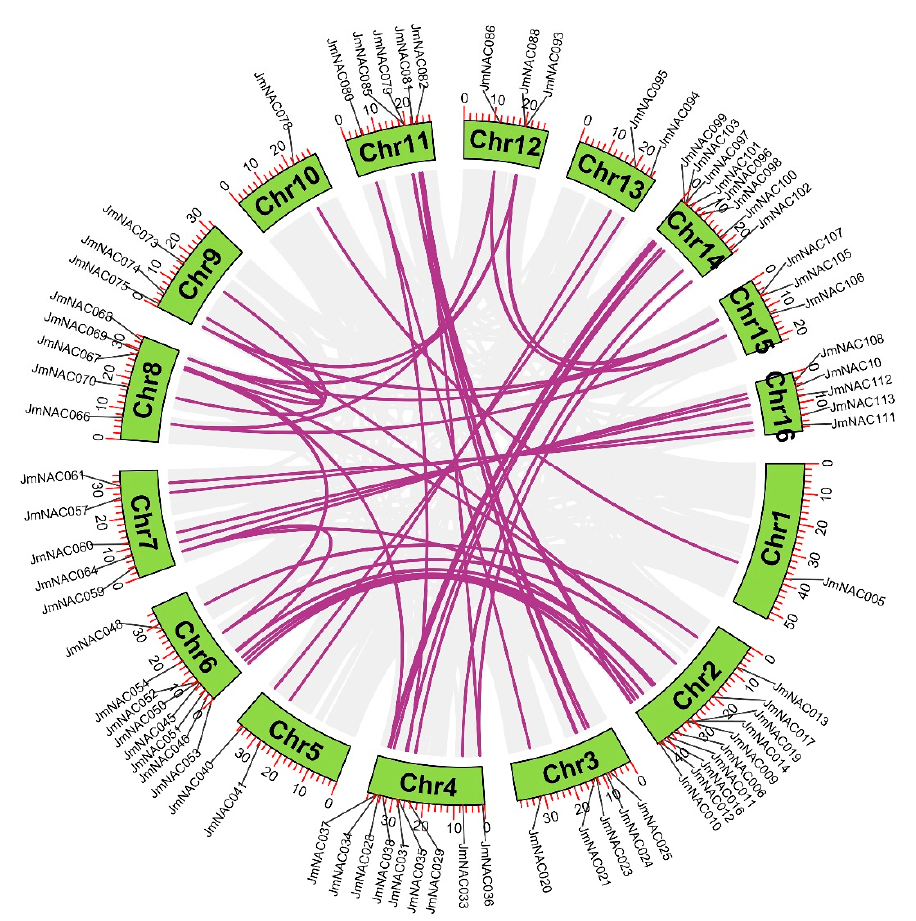
Figure 5. Genomic localization and gene duplication of JmNAC genes on J. mandshurica chromosomes. Grey lines indicate all syntenic blocks in the J. mandshurica genome; purple lines indicate the inter-chromosomal relationships of JmNAC genes.